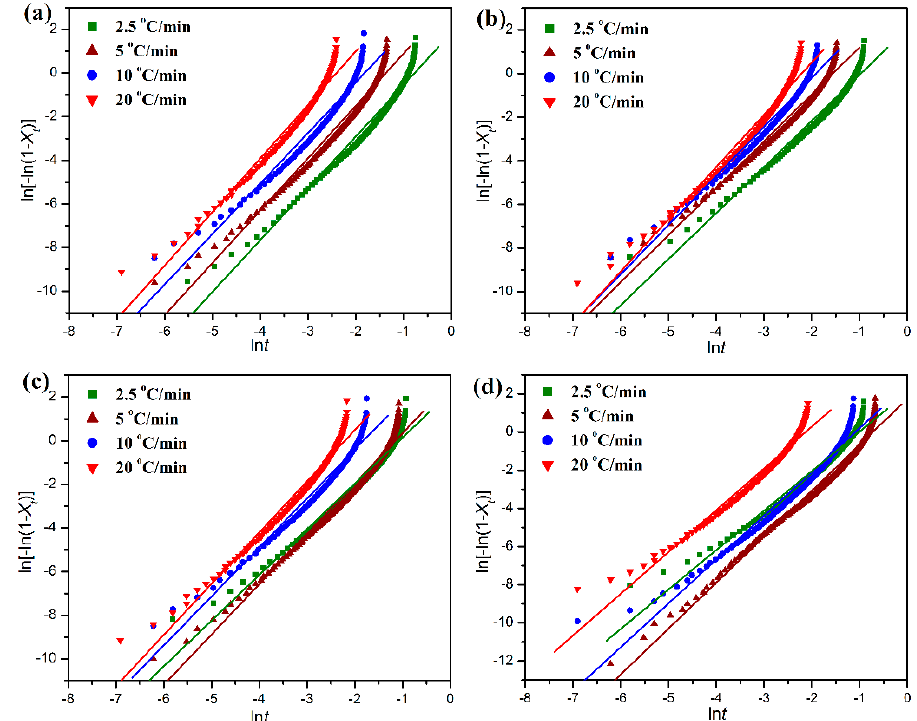
Figure 9. Avrami plots of ln[ − ln(1 − X t )] versus ln t for the non-isothermal crystallization of ( a ) pure POM and its blends with ( b ) 10 wt %, ( c ) 20 wt %, and ( d ) 40 wt % of PLA at different cooling rates.